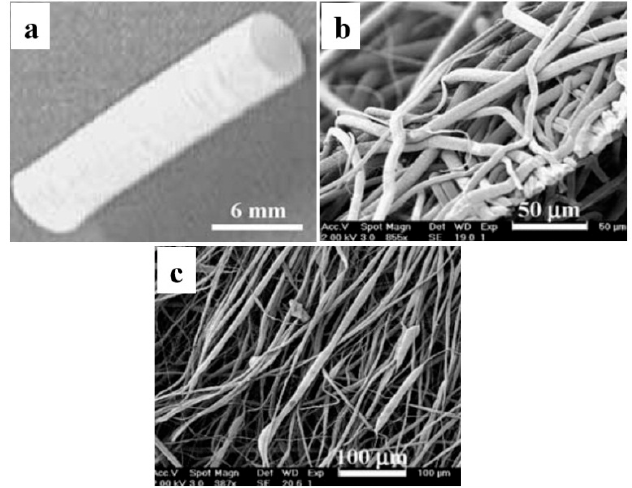
Figure 3. SEM photographs of ( a ) synthetic poly( ε -caprolactone) (PCL)/Poly( L -lactic acid) (PLA) blood vessel of 6 mm diameter, ( b ) the randomly oriented PCL fiber inner layer, ( c ) the aligned PLA fiber outer layer (reprinted from Ref. [34]).